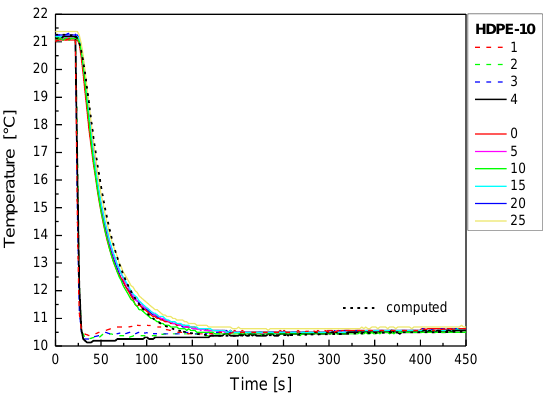
Figure 18. Time-history of measured temperatures and the temperatures computed in the probe axis (measurement A — water bath temperature of 10 °C/probe 2).